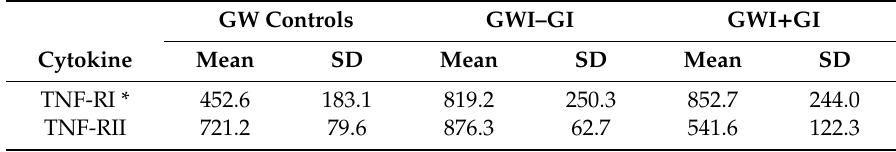
Table 2. TNF-RI and RII cytokine comparisons by GI symptom groups.